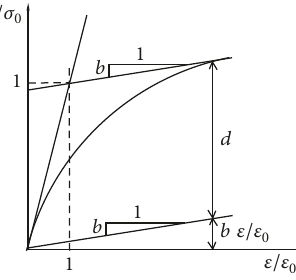
Figure 4: The Menegotto-Pinto material model for A283 steel